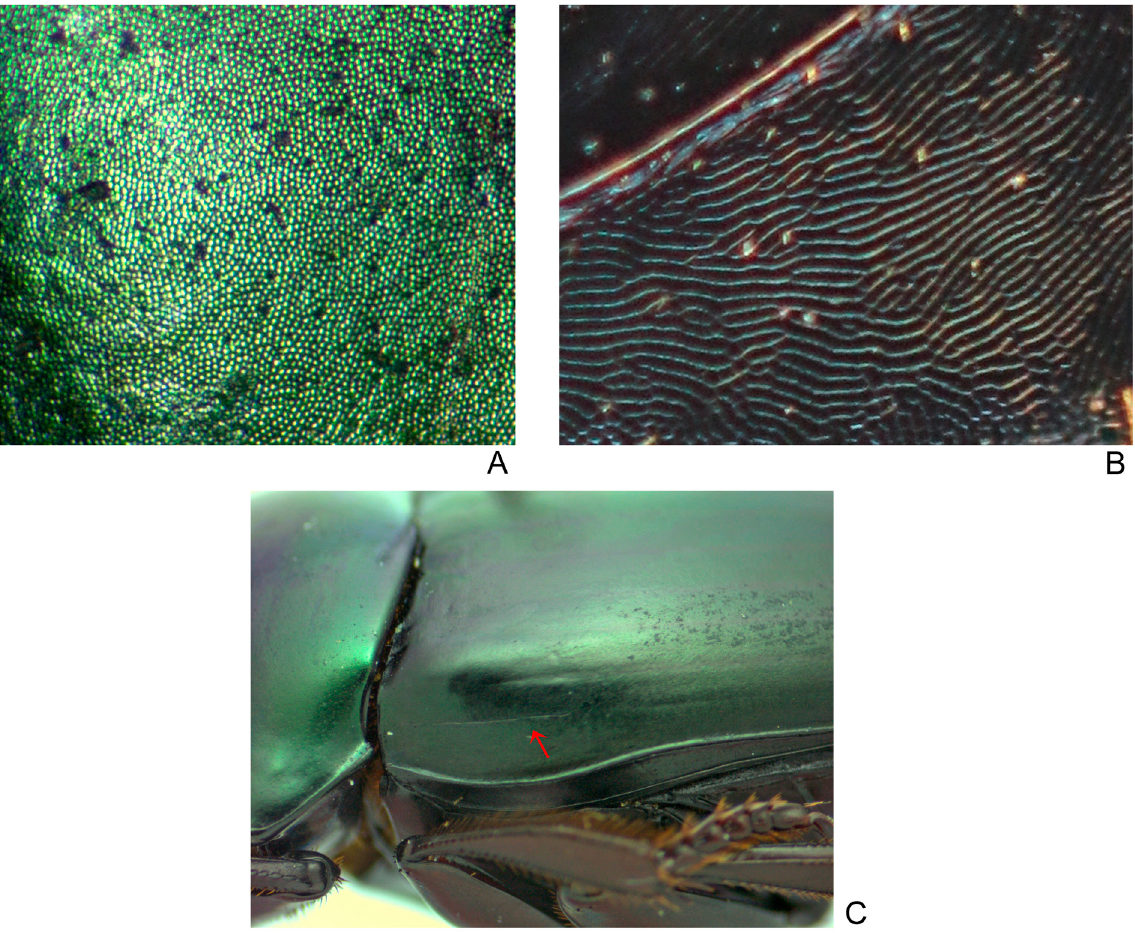
Fig. 12. Tegument variation in Sylvicanthon Halffter & Martínez, 1977. A . Tridimensional alveolar microsculpture of the elytra in S. proseni (Martínez, 1949) stat. et comb. nov.. B . Rivose microsculpture on the external side of metaventrite in S. obscurus (Schmidt, 1920) . C . S. proseni stat. et comb. nov., humeral carina, feature present also in S. aequinoctialis (Harold, 1869) and in about two-fifths of the studied specimens of S. obscurus (Schmidt, 1920)